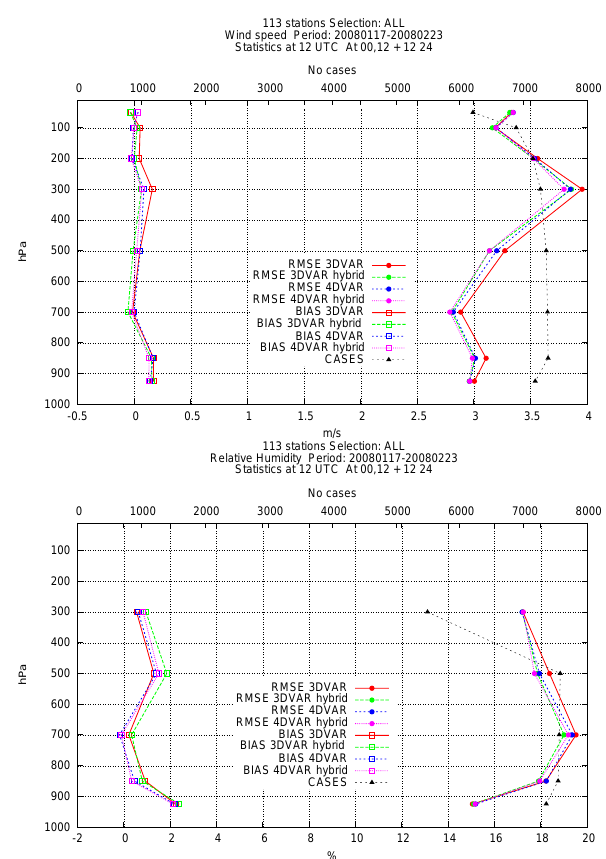
Fig. 12. Bias and standard deviation verification scores for wind speed (upper panel) and relative humidity (lower panel) profile forecasts as verified against radiosonde data in the whole forecast domain over the period 19 January–29 February 2008 and given as functions of forecast length. The control forecast from the 3D-Var (red curve), the 3D-Var hybrid (green curve), the 4D-Var (blue curve) and the 4D-Var hybrid (pink curve) experiments are included. The curve marked CASES indicates the number of observed values for the verification. Forecasts have been run with 6th hourly lateral boundary conditions.